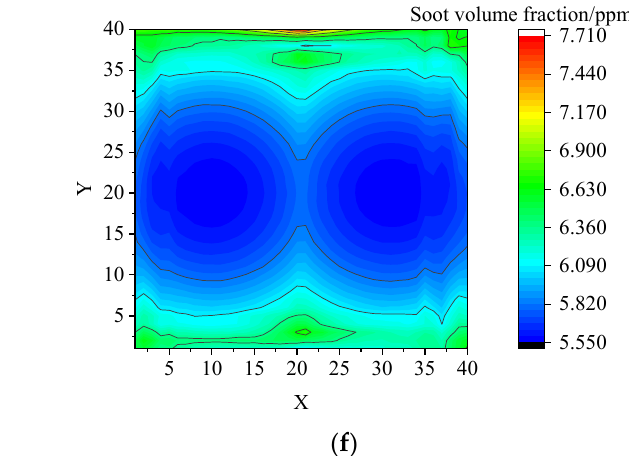
Figure 7. Reconstruction results of the two algorithms with different numbers of cameras: soot-concentration reconstruction results of the regularization algorithm at four cameras ( a ), six cameras ( c ) and twelve cameras ( e ) and the reconstruction results of the LSQR algorithm at four cameras ( b ), six cameras ( d ) and twelve cameras ( f ).